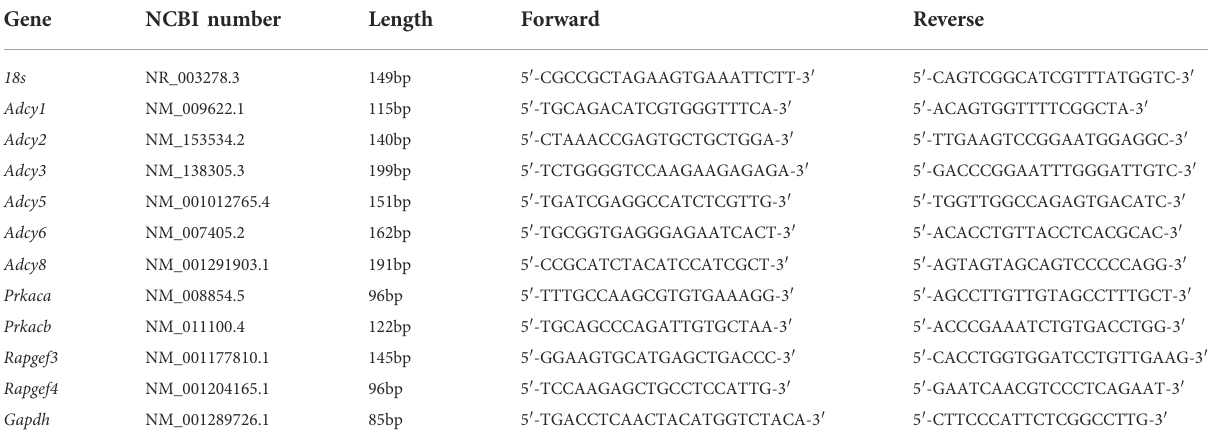
TABLE 2 Gene speci fi c primers used for qRT-PCR. The NCBI gene accession number, resulting base pair length, and both the forward and reverse primers for each gene for qRT-PCR analysis. Gene NCBI number